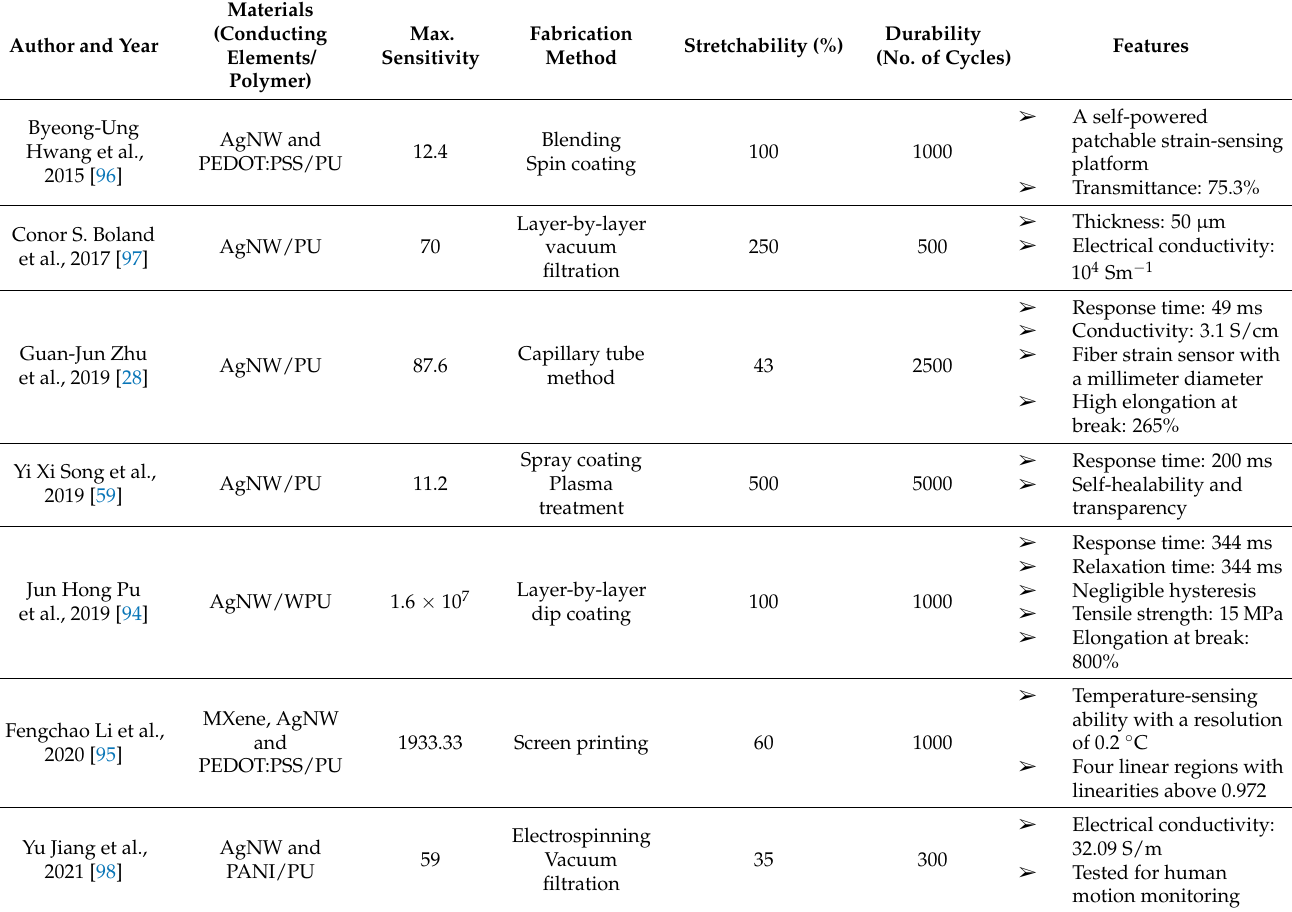
Table 4. Overview of a few research works on AgNW/PU-based stretchable strain